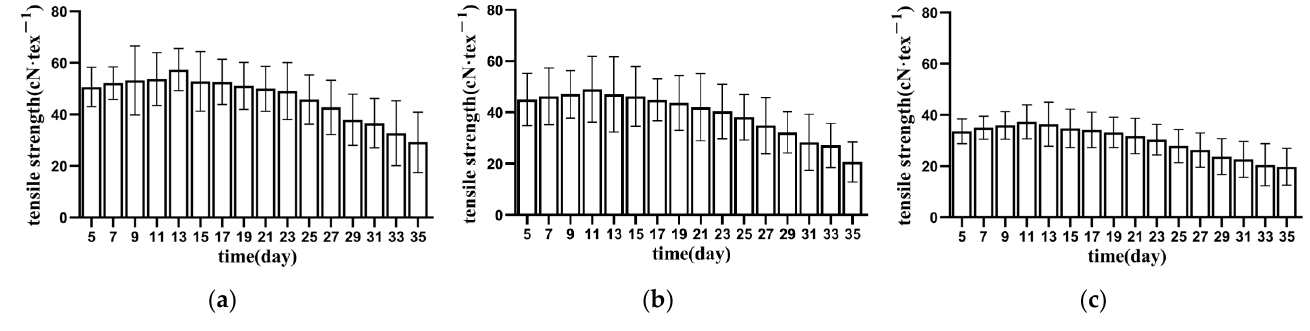
Figure 3. Tensile strength of inner banana stem fibres. ( a ) A Ⅰ ; ( b ) A Ⅱ ; ( c ) A Ⅲ .